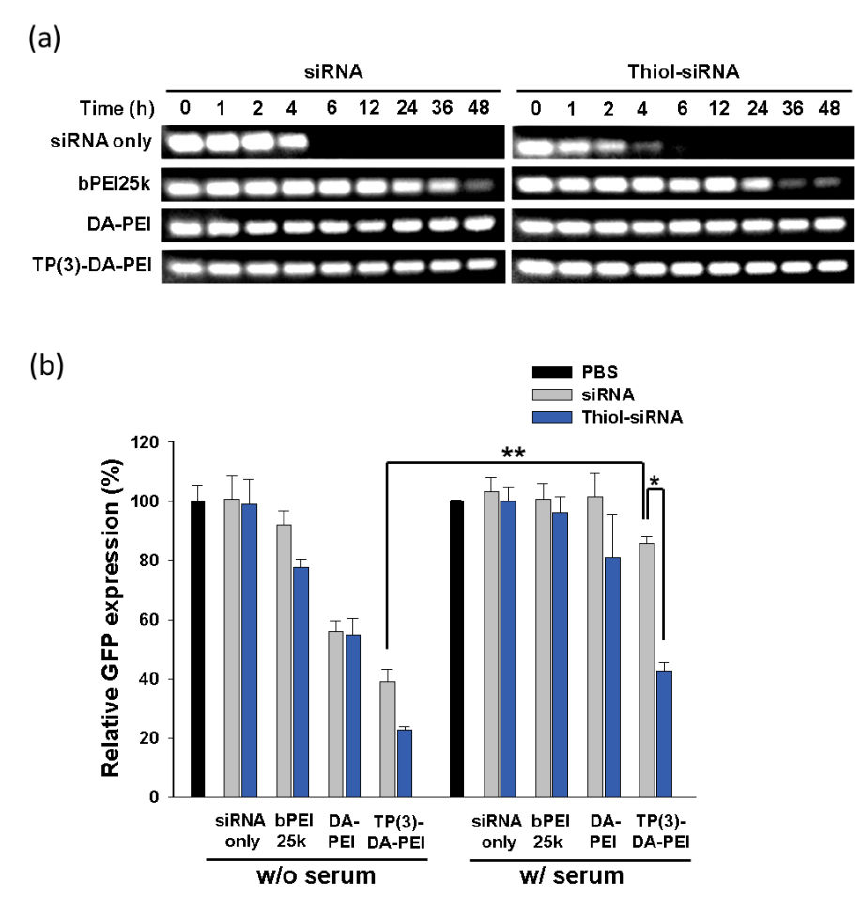
Figure 4. ( a ) Stability of siRNA and thiol-siRNA in the presence of 50% serum. Either siRNA or thiol-siRNA was complexed with the indicated polymers: bPEI25k (polymer/siRNA weight ratio = 1), DA-PEI (weight ratio = 3) and TP(3)-DA-PEI (weight ratio = 3). ( b ) Comparison of GFP gene silencing capability of various formulations in presence of 50% serum. The results are presented as means ± SD and analyzed using Student’s t -test ( n = 3, * p < 0.05, ** p <